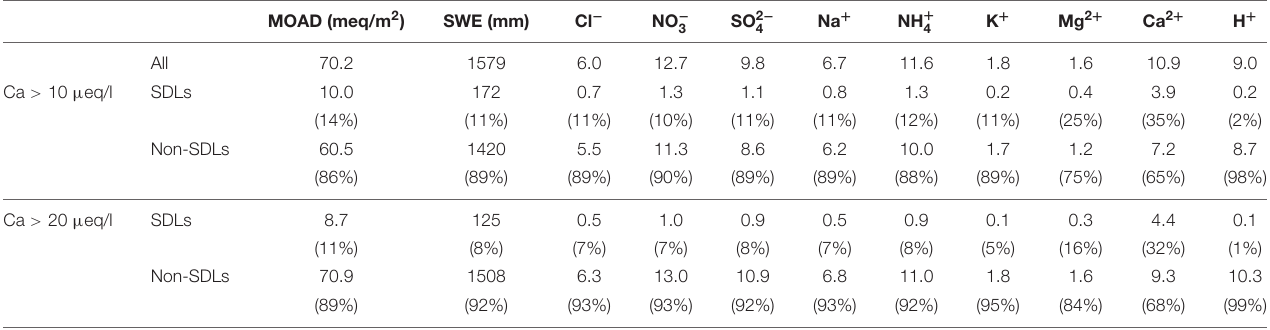
TABLE 4 | Mean relative ion composition of the mean overall annual depositions (MOAD) including all layers, as well as for SDLs and non-SDLs separately using the 10 µ eq/l Ca 2 + threshold. SO 2 − 4 Na + NH + 4 K + Mg 2 + Ca 2 + H + Cl − NO − 3 All Non-SDLs TABLE 5 | Mean overall annual depositions (MOAD) in meq/m 2 and snow water equivalent (SWE) in mm of all years (1987–2017) and all layers, SDLs and non-SDLs as well as the absolute and relative contribution of the respective ions. MOAD (meq/m 2 ) All